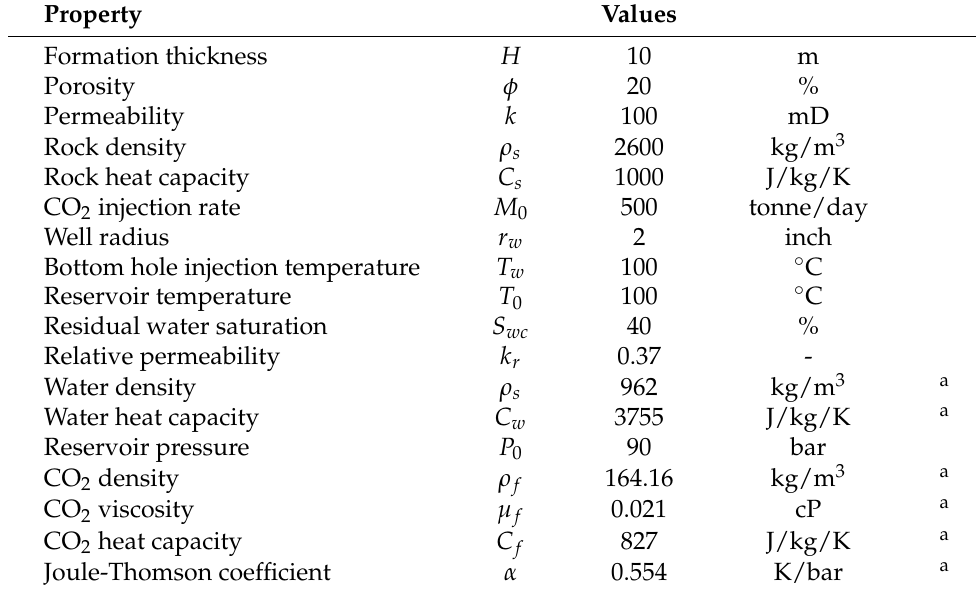
Table A4. Summary of the input parameters for the estimation of Joule–Thomson cooling in a near wellbore region based on the mathematical model by Mathias et al.